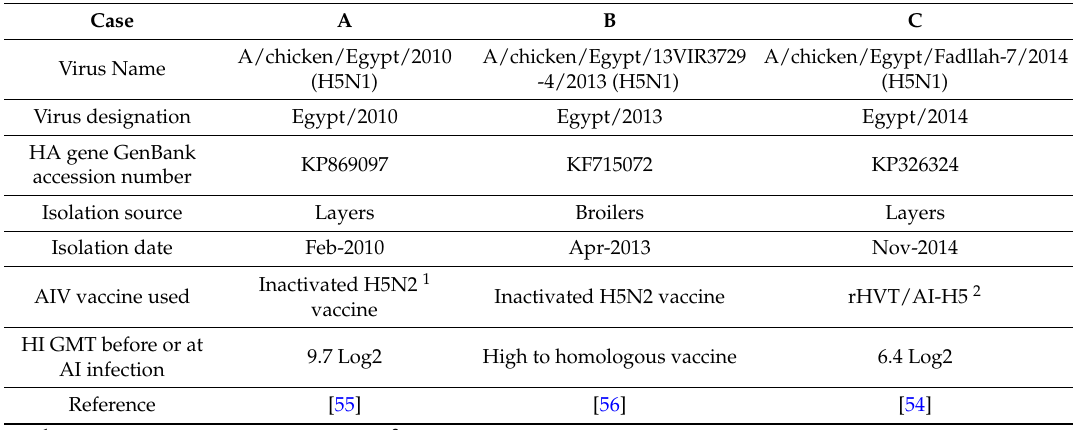
Table 3. Egyptian avian influenza (AI) H5N1 viruses isolated from vaccinated